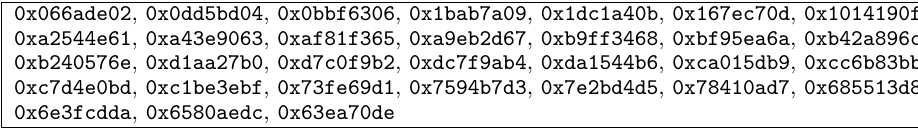
Table 6: All 31 choices for Λ such that Λ 0 ∈ S and Λ 00 ∈